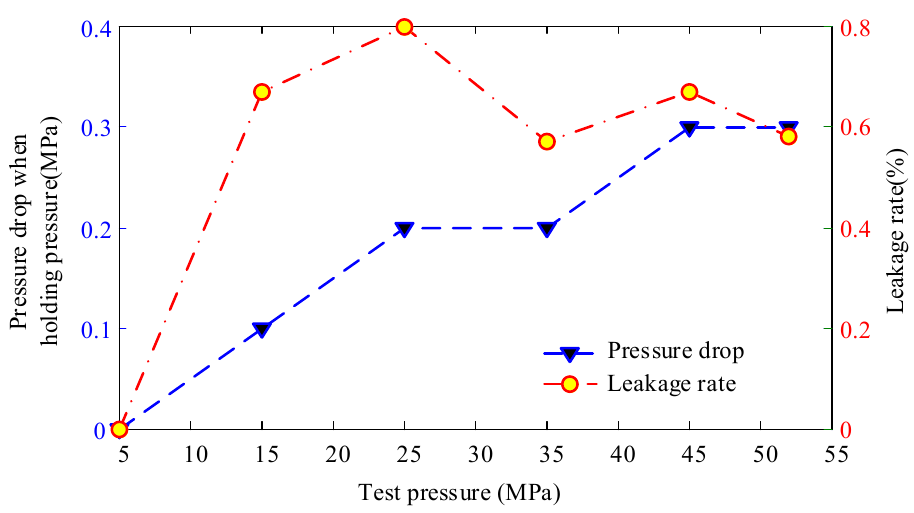
Figure 24. Pressure drop and leakage rate for the experimental device.